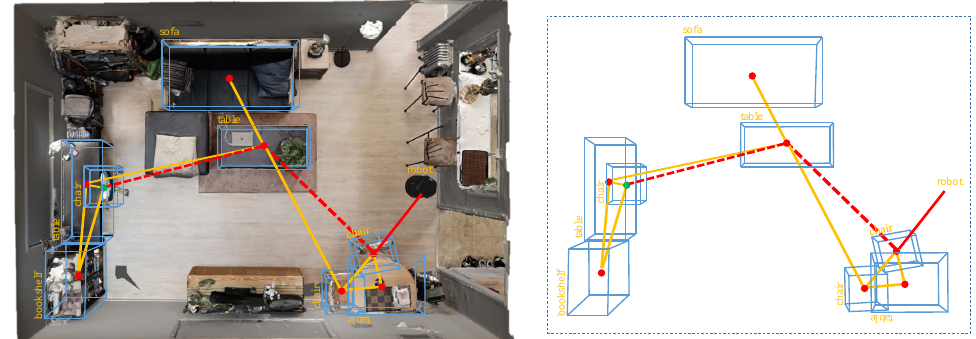
Figure 3. Illustration of the object-based heuristic graph search. The red dashed line indicates the shortest global topological path.